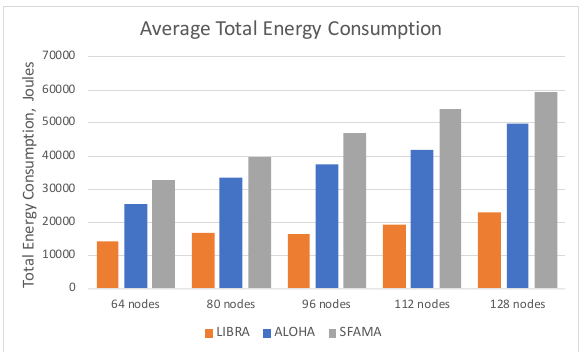
Figure 6. Average total energy consumption,